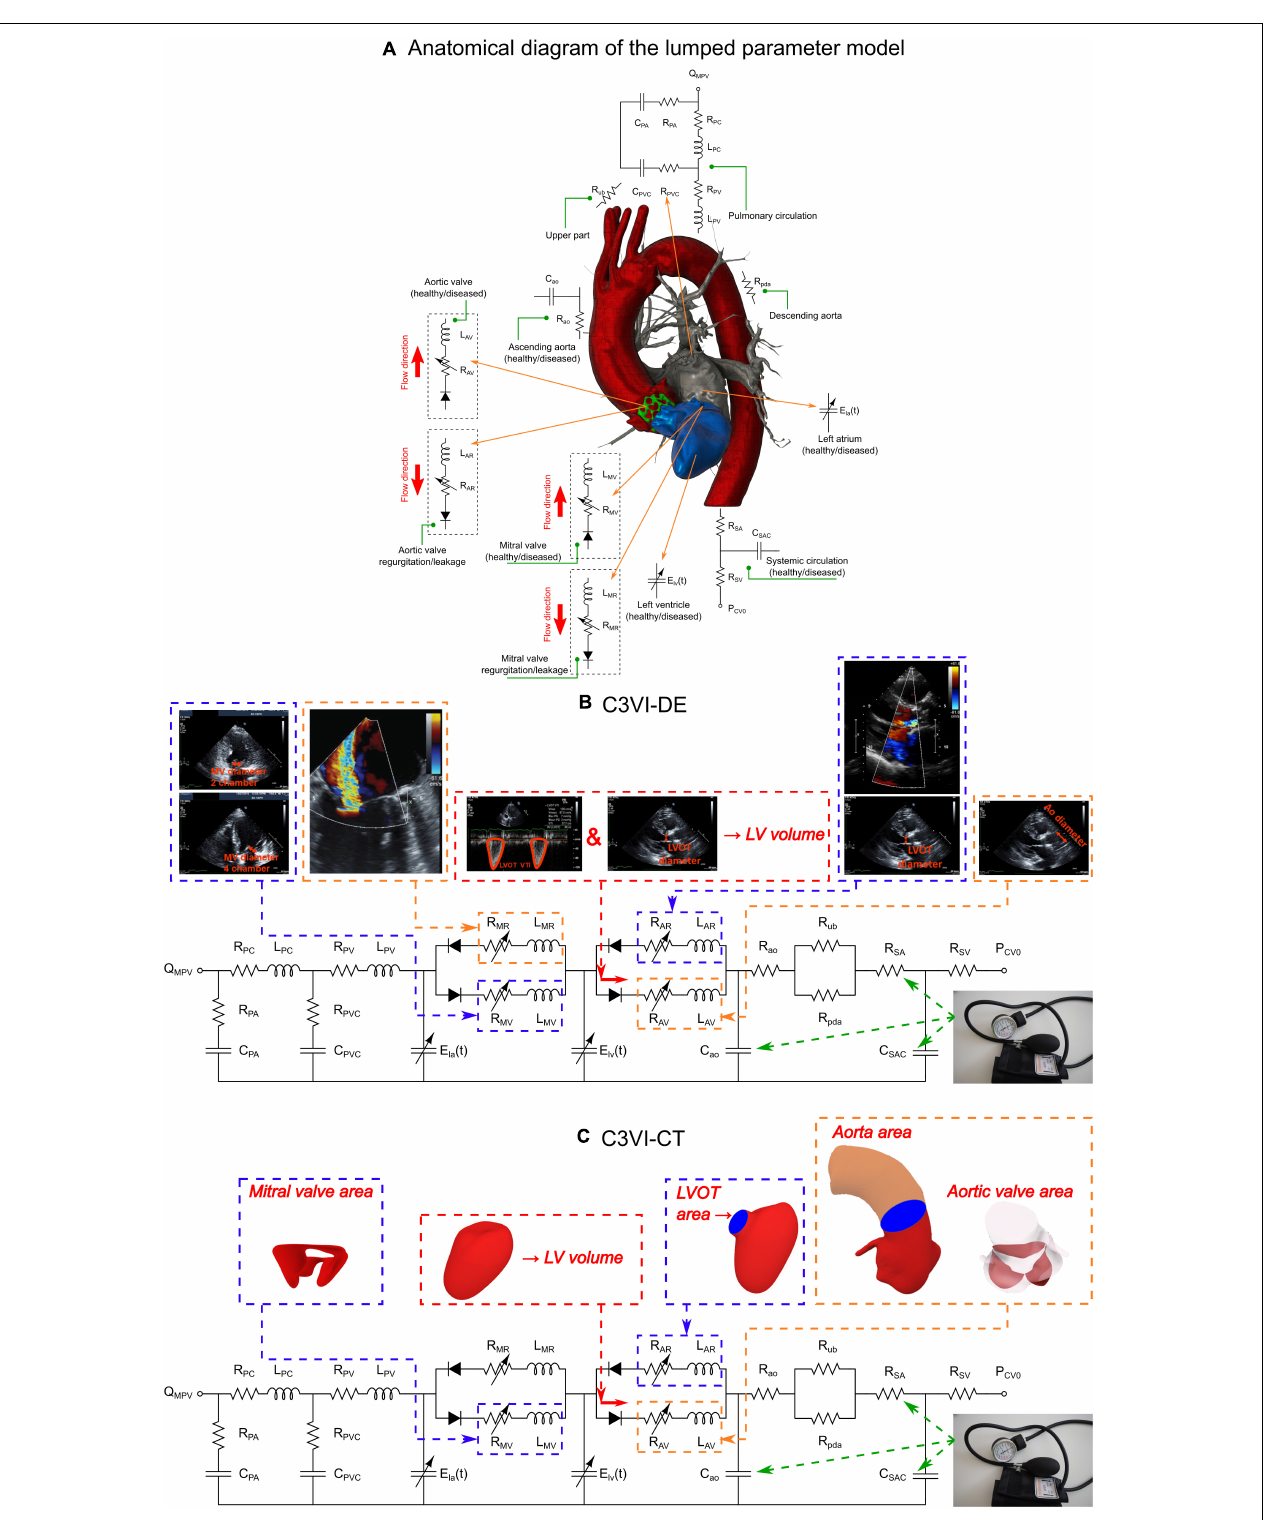
FIGURE 1 | Schematic diagram of the lumped parameter modeling. (A) Anatomical representation. (B) Electrical representation of C3VI-DE. This model includes four sub-models. (1) left atrium, (2) left ventricle, (3) aortic valve, (4) mitral valve, (5) systemic circulation, and (6) pulmonary circulation ( Table 1 , abbreviations). C3VI-DE input parameters were measured using DE and sphygmomanometer. (C) Electrical representation of C3VI-CT. Input parameters of C3VI-CT were measured using CT and sphygmomanometer.